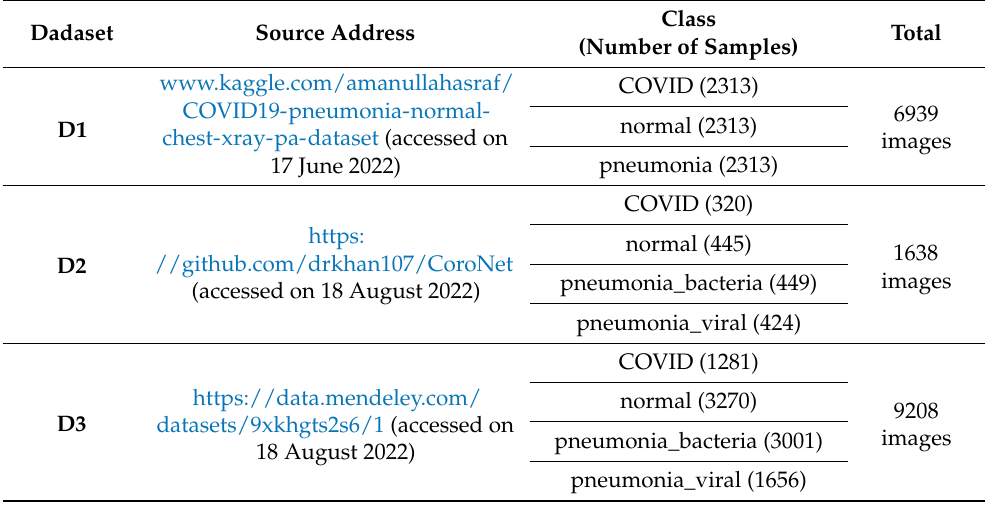
Table 1. Specific composition of D1, D2 and D3.